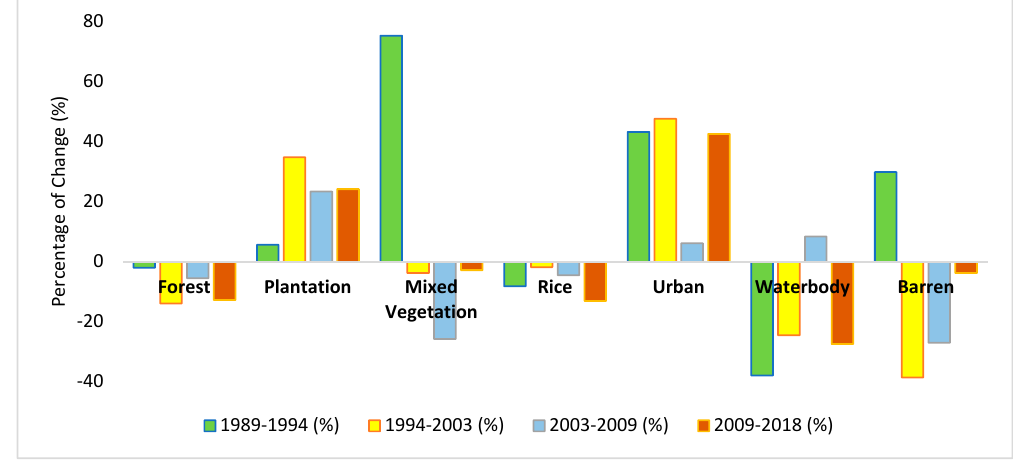
Figure 4. The percentage of land uses change (1989–2018).